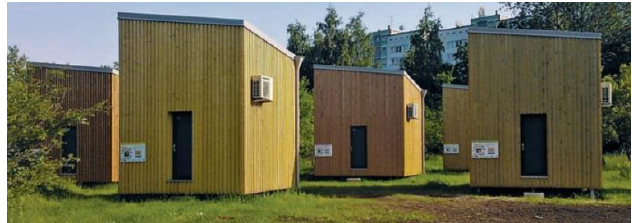
Fig. 1. Experimental test